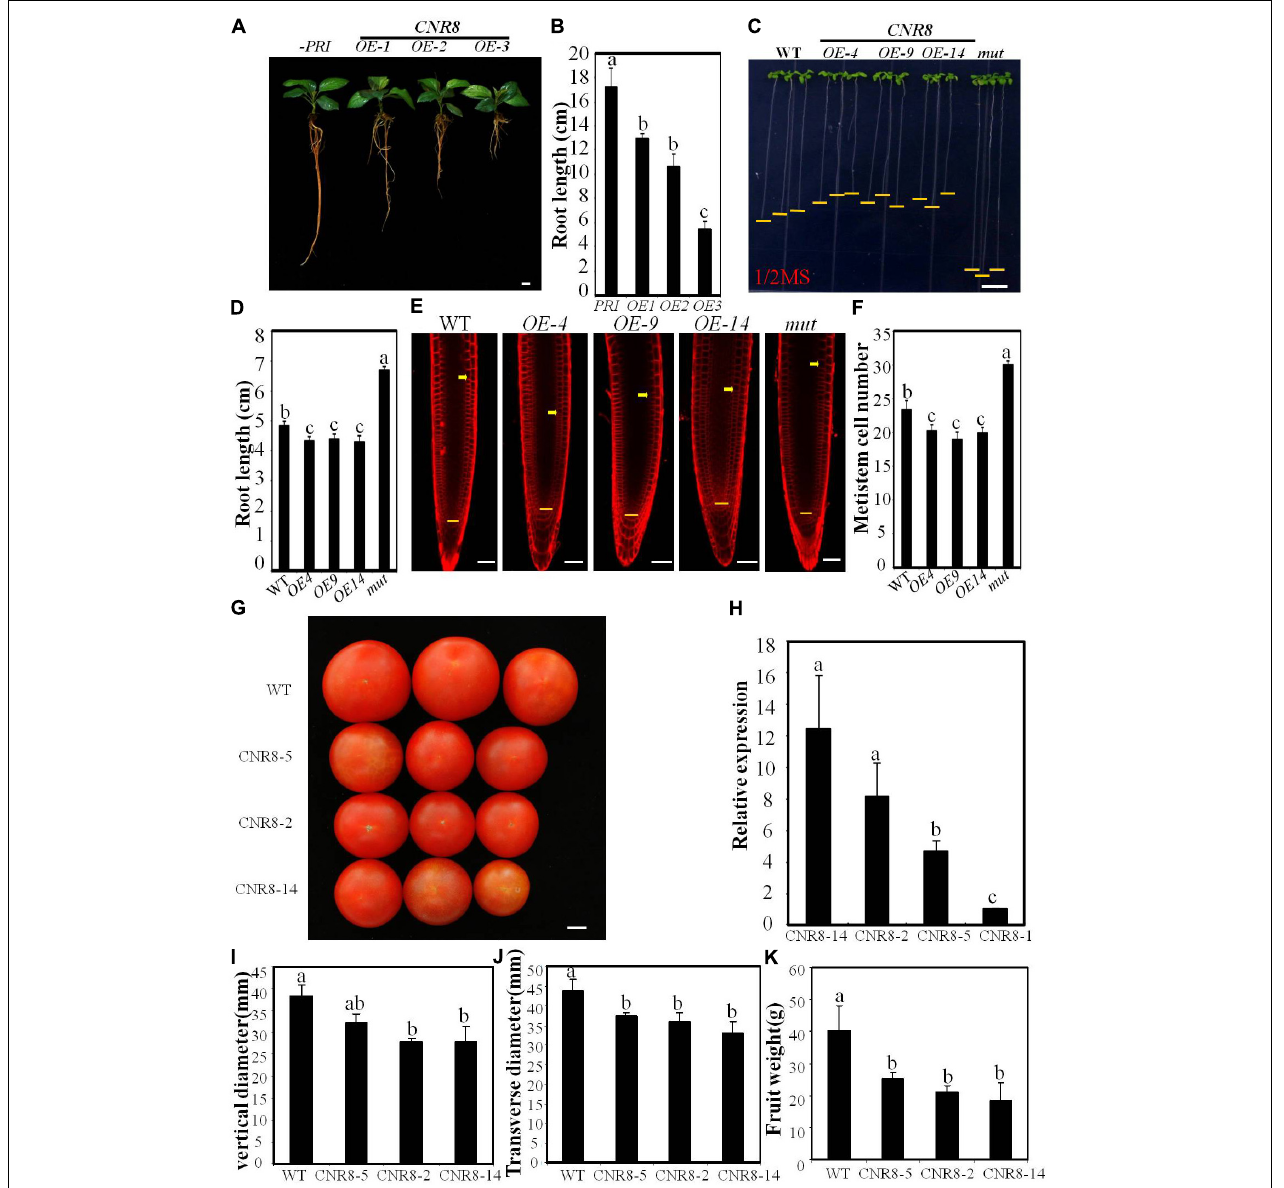
FIGURE 1 | Phenotypes of MdCNR8 transgenic lines. (A) The 40-day-old seedlings of MdCNR8 overexpression lines (OE-1, OE-2, and OE-3) and the control line infected with empty vector. Bars = 1 cm. (B) Primary root length of 40-day-old apple seedlings of empty control, OE1, OE2, and OE3. Mean values were shown with their SD ( n = 11 to 20). (C) Root phenotypes of the WT, MdCNR8 overexpression lines (OE-4, OE-9, and OE-14) and atcnr8 mutant (mut) grown for 7 days on 1/2 MS medium. Bars = 1 cm. (D) Primary root length of the 7-day-old Arabidopsis seedlings of WT, OE-4, OE-9, OE-14, and atcnr8 mutant. Mean values were shown with their SD ( n = 11 to 20). (E) Confocal microscopy images of the FM4-64-stained Arabidopsis seedlings of WT, MdCNR8 overexpression lines (OE-4, OE-9, OE-14) and atcnr8 mutant (mut). Yellow arrows and horizontal lines indicate the approximate position of root meristem zone. Bars = 50 µ m. (F) Meristem cell number of Arabidopsis seedlings of WT, OE-4, OE-9, OE-14, and atcnr8 mutant (mut). Cell number of 7-day-old roots was counted and shown as averages ± SD ( n = 5 to 10). (G) Mature tomato fruit phenotypes of the WT and MdCNR8 overexpression lines (OE-2, OE-5, OE-14). Bars = 1 cm. (H) qRT-PCR of MdCNR8 in tomato plants. Data are the means ± SD of three biological repeats. SlACTIN was used as an internal control. (I–K) Quantification of vertical diameter, transverse diameter and fruit weight of the WT, OE-2, OE-5, and OE-14 in (G) . Different letters on each bars denote significant differences ( p < 0.01, ANOVA, Tukey’s